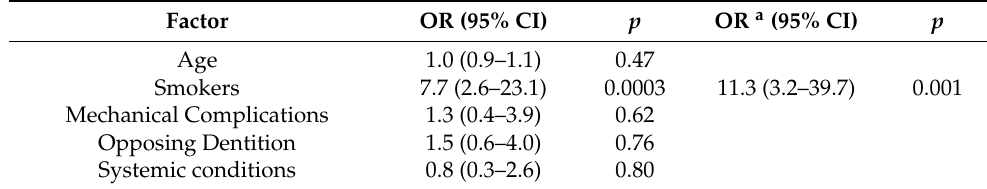
Table 4. Risk indicators for Biological Complications (OR stands for Odds Ratio, while CI stands for Confidence Interval, p < 0.05 was considered statistically significant, we replicate the test for significant results